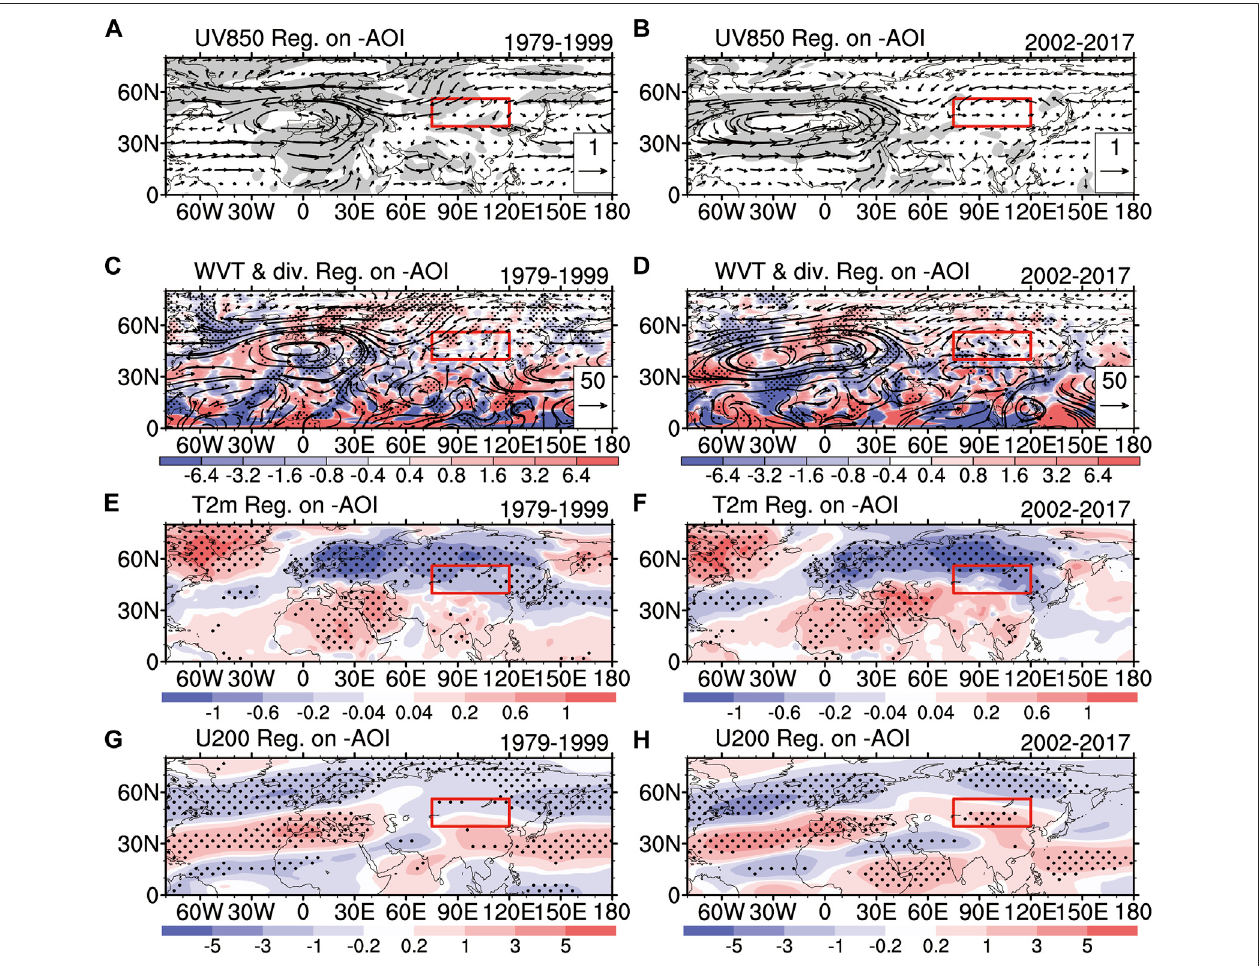
FIGURE3| Regressionmapsofthe (A,B) horizontalwind(units:m s − 1 )at850 hPa, (C,D) verticallyintegrated(surfaceto300 hPa)watervaportransport(vectors; units: kg m − 1 s − 1 ) and its divergence (shading, 10 – 6 kg m − 2 s − 1 ), (E, F) air temperature (units: ° C) at 2-m, and (G, H) zonal wind (units: m s − 1 ) at 200 hPa upon − AOI during (left panel) 1979 – 1999 and (right panel) 2002 – 2017. The red frame denotes the location of the study area (40 ° – 56 ° N, 75 ° – 120 ° E). The shaded areas in (A, B) and the dotted areas in (C, D, E, F, G, H) indicate statistical signi fi cance at the 95% con fi dence level based on the Student ’ s t -test.